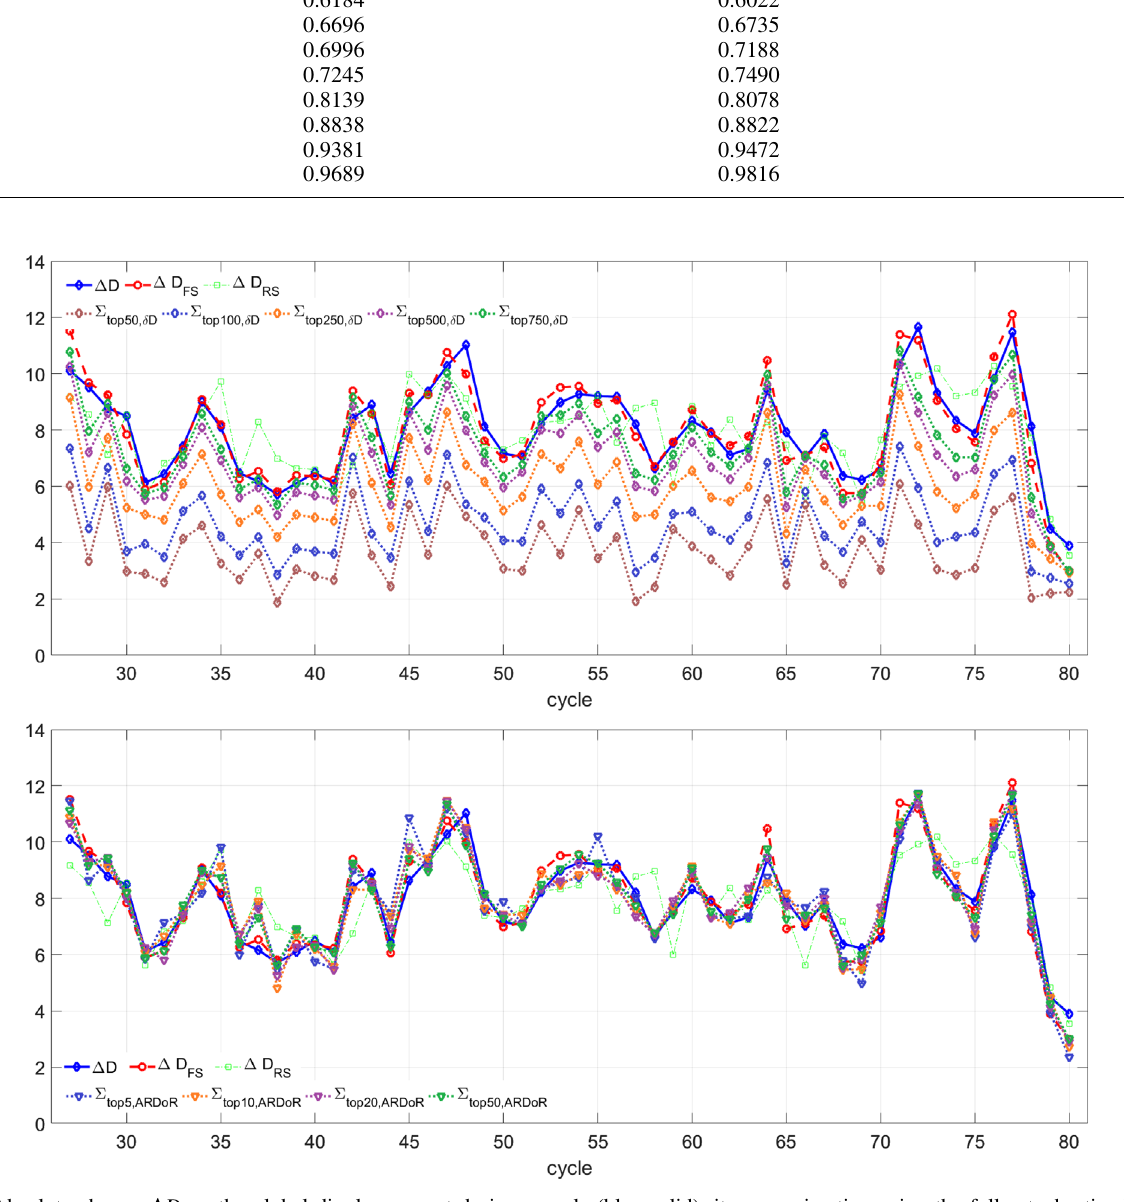
Fig. 3. Absolute change D D on the global dipole moment during a cycle (blue solid); its approximation using the fully stochastic algebraic method (red dashed) and the reduced stochasticity algebraic method (light green dashed). The curves are compared with the absolute change computed with the algebraic method for various sets of the active regions in a cycle. Top panel : subsets containing ARs with the top N highest ultimate dipole contribution (FS case). Bottom panel : subsets containing ARs with the top N highest ARDoR values added to D D RS